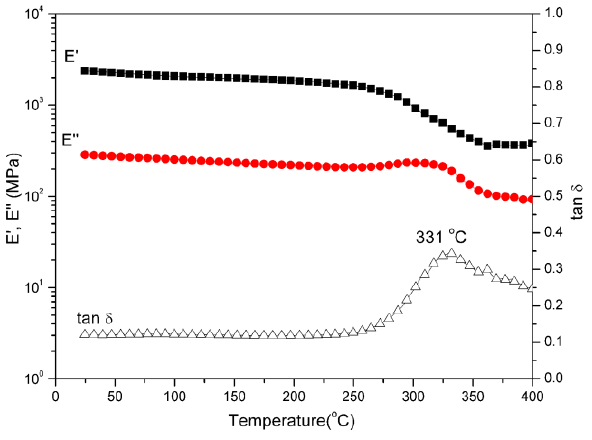
Figure 4. Dynamic mechanical spectra of poly(Dd-hda) Xmain .